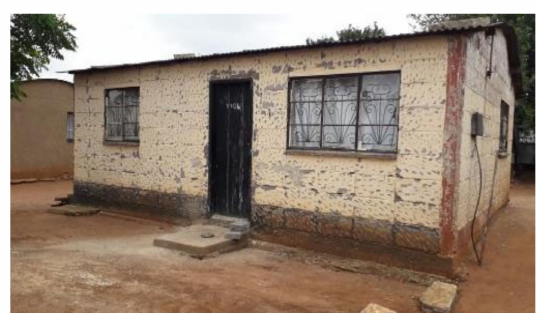
Figure 7. Apartheid era (matchbox) houses found in eSizameleni (Wakkerstroom), with a surface area of 40 m 2 . The houses had either asbestos or corrugated iron roofing with 2 doors and 3–4